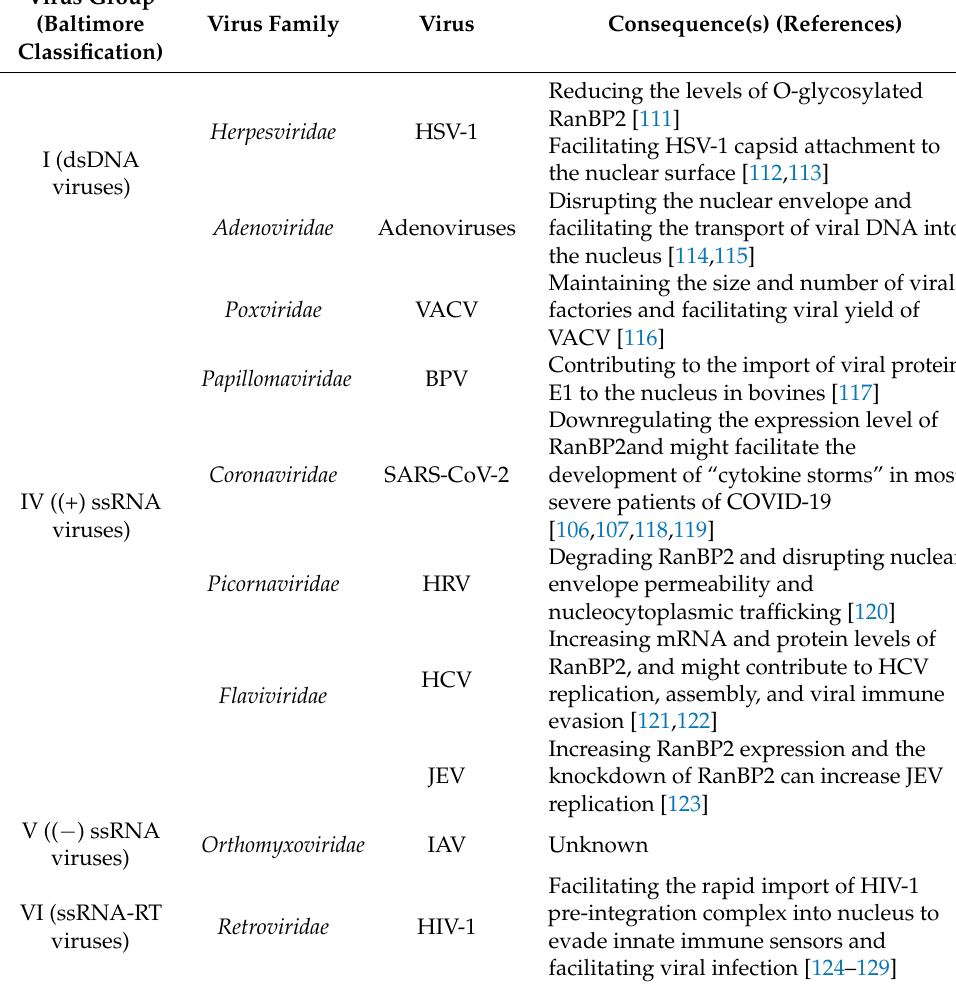
Table 2. The interaction between RanBP2 with distinct